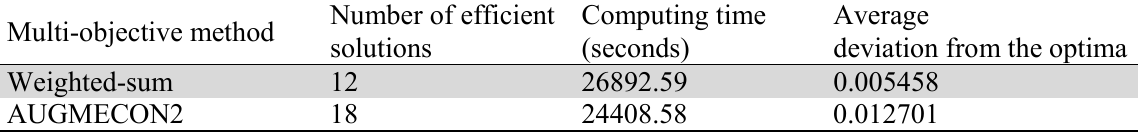
Results for the second scenario and twenty grid points. Multi-objective